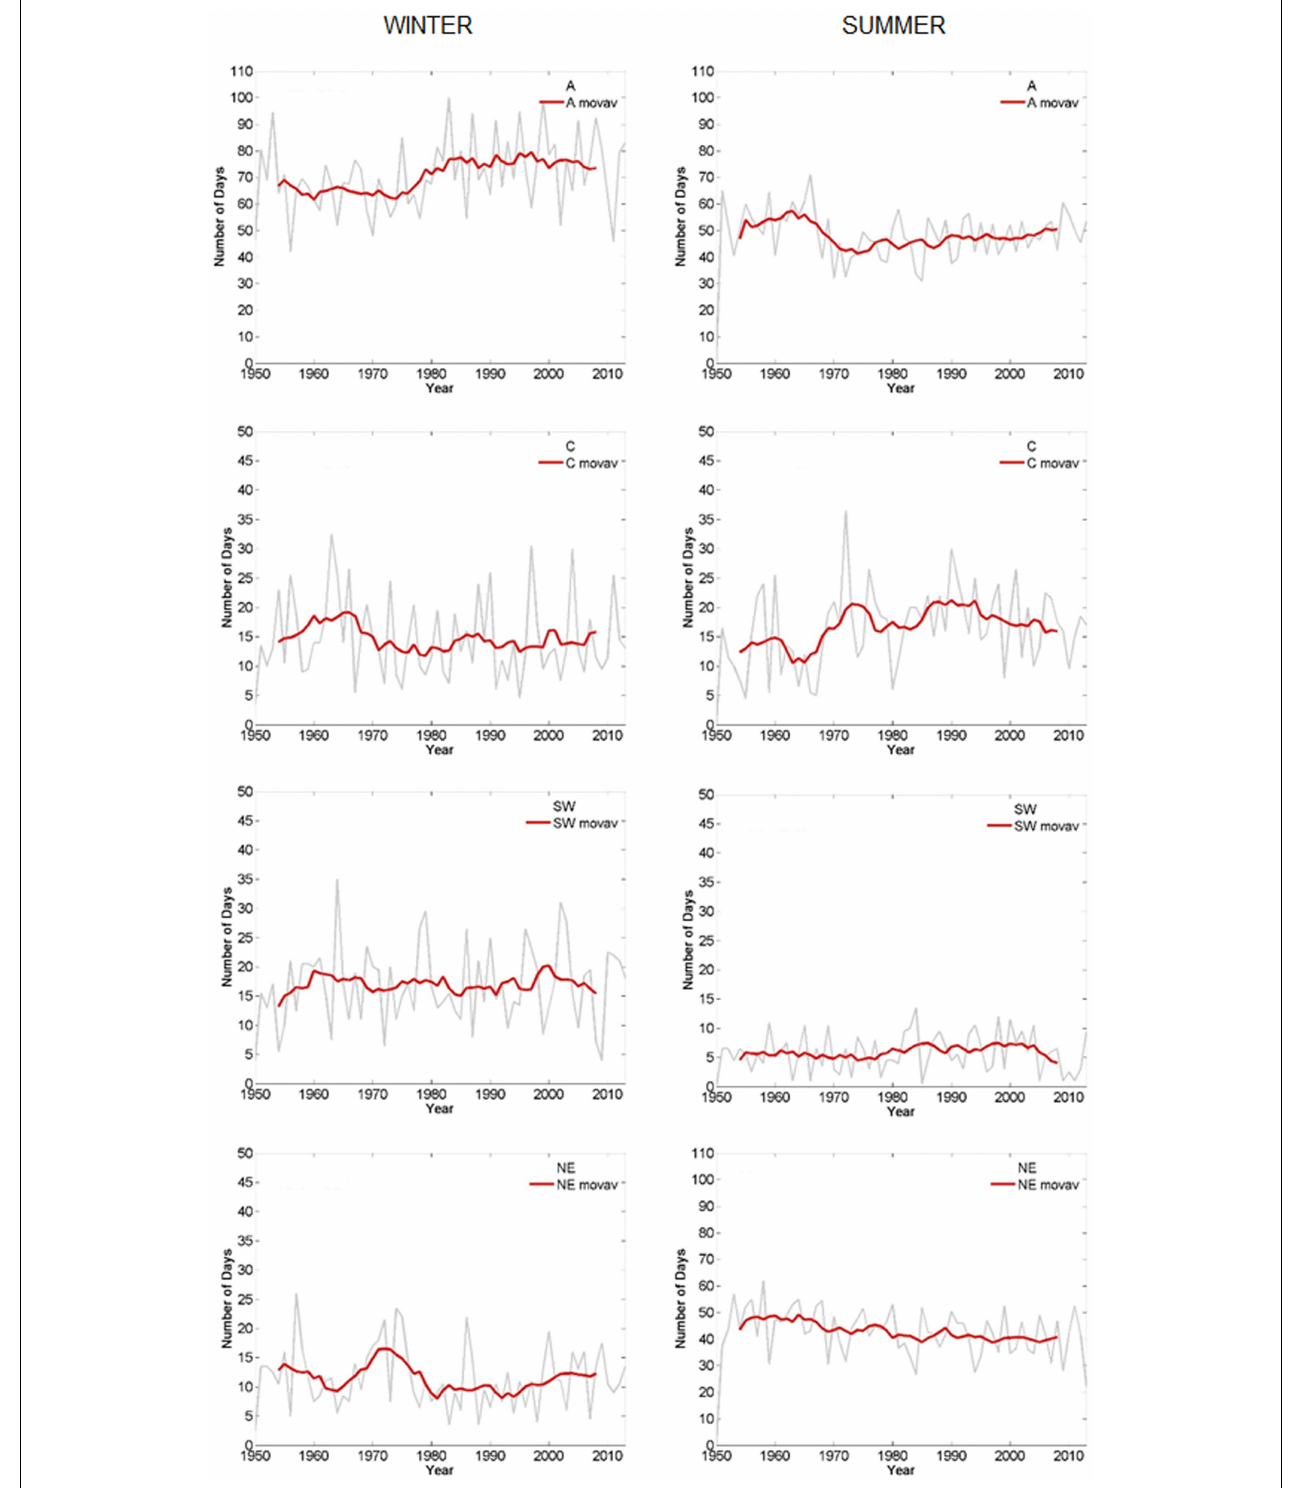
FIGURE 3 | Evolution of the frequency of different CWTs for winter (left panel) and summer (right panel). Red line indicates a moving average of 9 years.